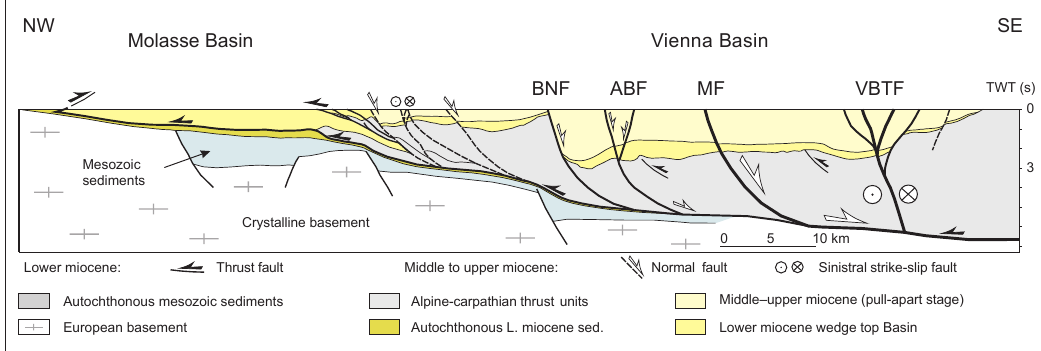
Figure 2. Cross section through the Vienna Basin at its central part based on reflection seismic and deep boreholes, indicating the common detachment of the Alpine floor thrust, which links the normal splay faults such as the Markgrafneusiedl Fault (MF), Aderklaa–Bockfliess Fault (ABF), and Bisamberg–Nussdorf Fault (BNF) to the Vienna Basin Transfer Fault (VBTF). The generalized detachment corresponds to the Alpine–Carpathian floor thrust, which is reactivated by normal faulting. For location see Fig.